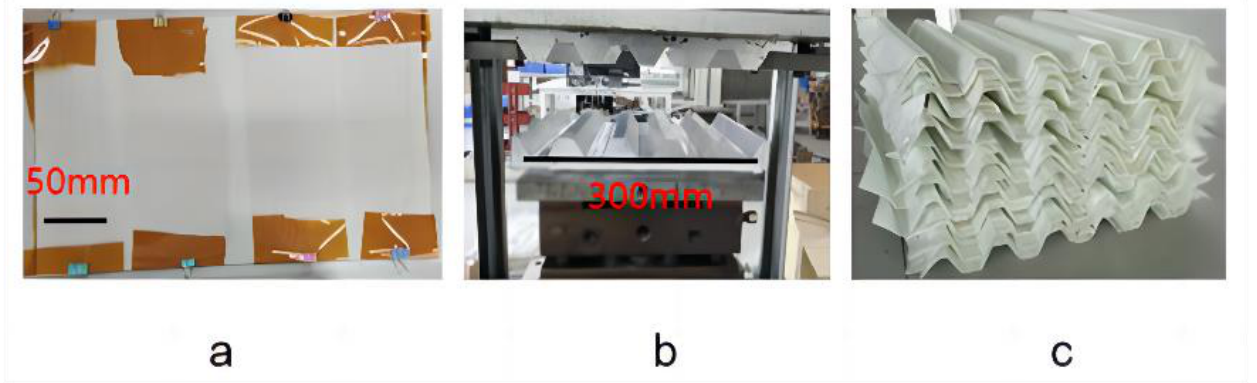
Figure 1. ( a ). GF/PP prepreg ( b ). Corrugated mold ( c ). Corrugated core material after hot compres- sion molding.